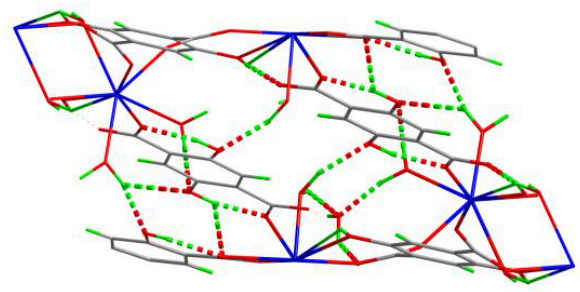
Figure 4. Hydrogen bonds (green dotted line).